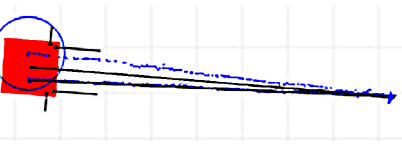
Figure 8. Rotation correction factor determination by using the IPS in the first iteration.